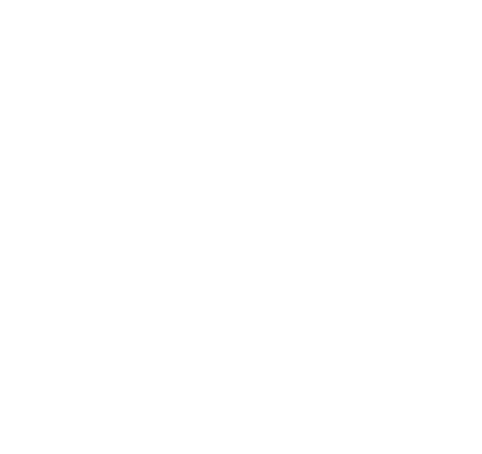
Figure 6. WSSH ROC using sensitivity and specificity